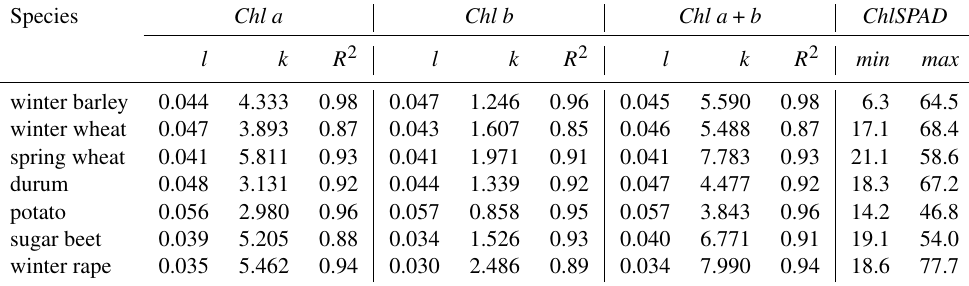
Table 4. Coefficients k and l of the exponential calibration functions (Eq. 3) for the conversion of ChlSPAD values into Chl a , Chl b , and Chl a+b content (in µgcm − 2 ), corresponding coefficients of determination (Pearson’s R 2 ), and range of ChlSPAD values involved in the calibration